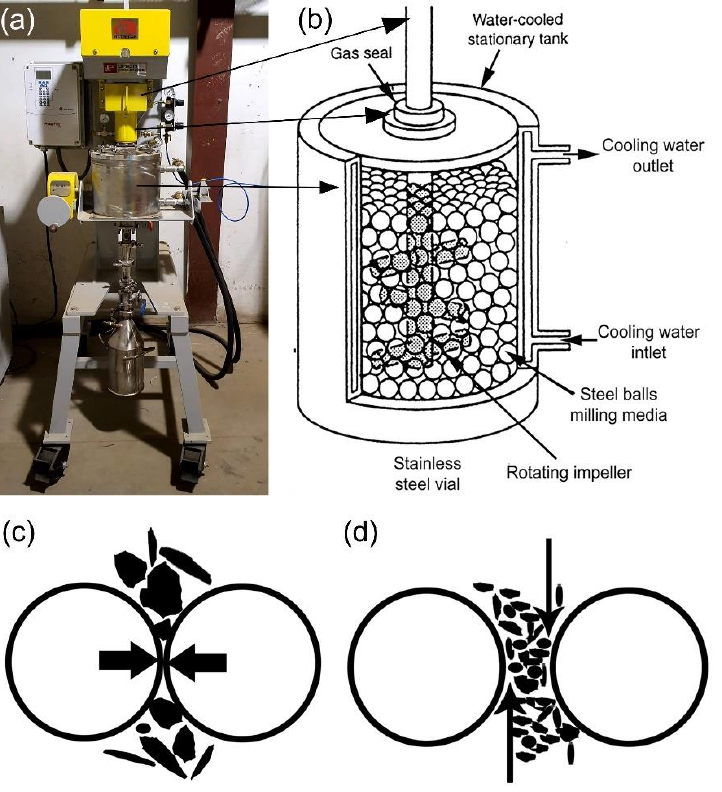
Figure 3. ( a ) A Photo of an attritor ball mill; sketches illustrate ( b ) ball movement inside attritor ball mill, ( c ) impact, and ( d ) shear forces generated by the ball milling media. The equipment is housed in the Nanotechnology and Applications Program (NAP), Energy and Building Research Center (EBRC), Kuwait Institute for Scientific Research (KISR).